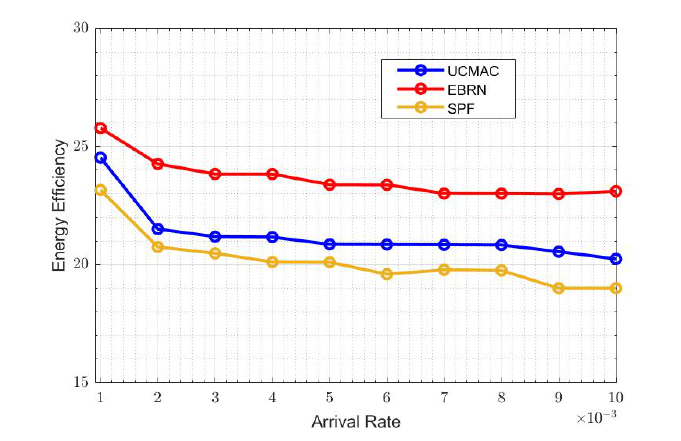
Figure 13. Energy Efficiency.